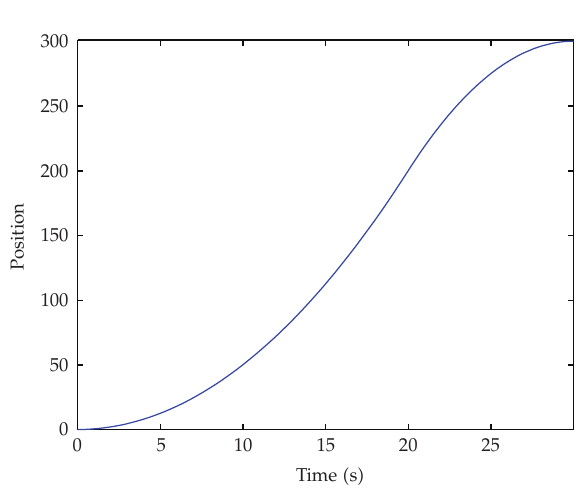
Figure 1: States x (cid:5) t (cid:6) as functions of time t for the Bang-Bang control problem for α (cid:7)